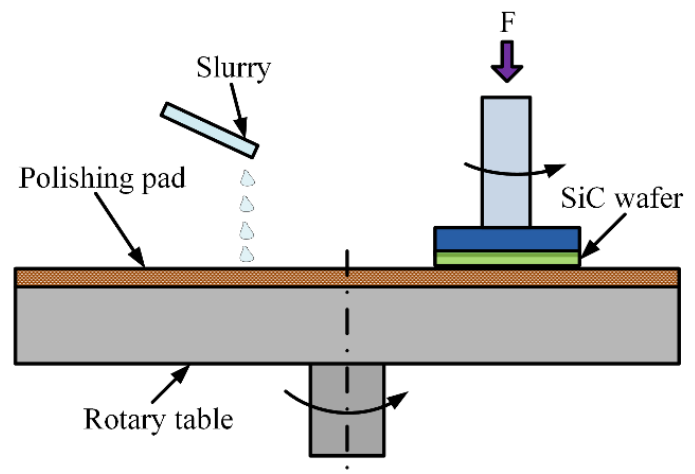
Figure 2. Schematic structure of the CMP setup [21]. CMP of single-crystal SiC was first reported by Zhou [22] in 1997. He found that chemical reactions of CMP could be improved by increasing the temperature (T) and the pH of the slurry. A higher pH value increased the chemical reaction rate by increasing the concentration of the OH − groups, which weakened the Si-C bonds. Additionally, since chemical reactions were thermally activated processes and generally obey the Arrhenius relationship, increasing the slurry temperature and/or the temperature at the pad surface was also an effective means of enhancing the chemical etching. A smooth defect-free surface with Sq = 0.5 nm was obtained when the pH = 11 and T = 55 ◦ C, but the MRR was very low (<0.2 µ m/h). The results showed that the quality of CMP depended on the balance between the oxidation reaction rate and the oxide layer’s removal rate. Chen [11,23] investigated the zeta potentials of SiO 2 and CeO 2 particles in the presence of KMnO 4 in the pH range of 2 to 10. Both the zeta potentials of SiO 2 and CeO 2 particles decreased with the increase in pH values, as shown in Figure 3. SiO 2 particles were negatively charged in the entire pH range, while CeO 2 particles were positively charged over the pH range of 2–8 and negatively charged above pH 8. The isoelectric point of SiC in DI water is about 5. Therefore, when the pH value was 2~5, the positively charged SiC surface was repelled by CeO 2 particles. On the contrary, when the pH value was less than 5, the mutual attraction between negatively charged SiO 2 particles and a positively charged SiC surface led to the reduction of the surface oxidation area of SiC, which would significantly reduce the friction coefficient and MRR during 6H-SiC’s CMP process. Neslen [24] studied the effects of temperature, slurry pH, applied pressure, and polishing rotation rate on the MRR of 4H-SiC during CMP using a colloidal silica slurry and polyurethane/polyester fiber polishing pads. It was